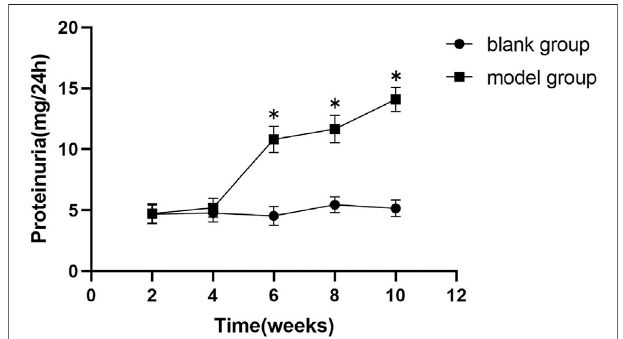
FIGURE 2 | The 24 h proteinuria of the model group rats increases signi fi cantly from the week 6 of the experiment. Data are expressed as means ± standard deviation (SD). * p < 0.01 vs. blank group.